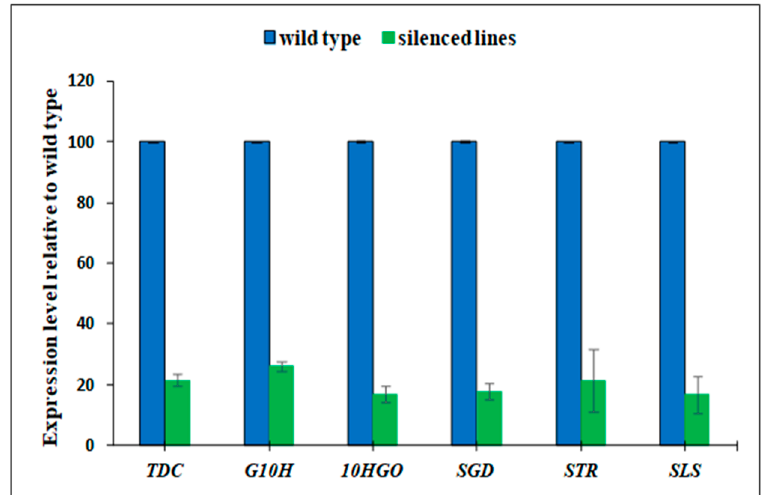
Figure 2. Real-time reverse transcriptase PCR of the mRNA translating tryptophan decarboxylase (TDC), geraniol 10-hydroxylase (G10H), 10-hydroxygeraniol (10HGO), strictosidine β -glucosidase (SDG), strictosidine synthase (STR) and secologanin synthase (SLS). Levels of the silenced lines are normalized to 100% in the wild type line. The gene expression level of the silenced lines relative to the wild type is represented here. Values are mean of three independent replicates. Vertical bars show the standard deviation.